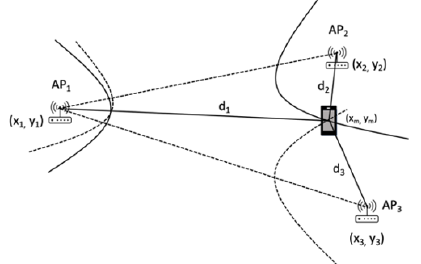
Figure 3: Finding a location via UWB using the TDOA